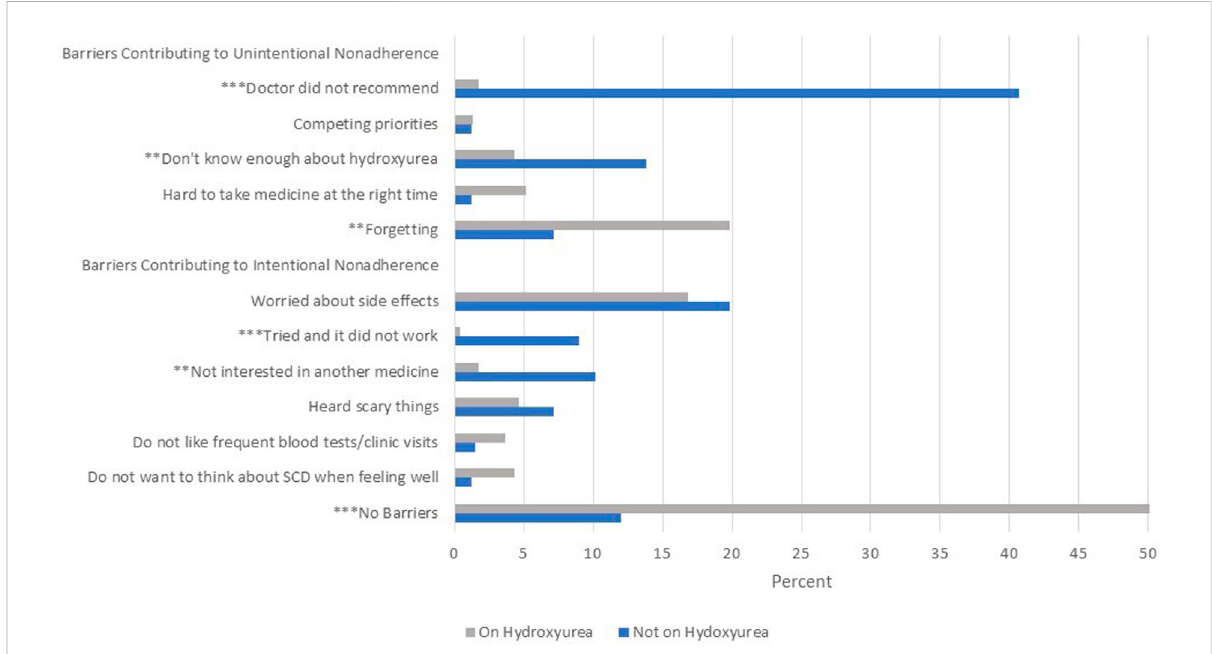
FIGURE 1 Barriers to hydroxyurea use as reported by adults and caregivers of children with sickle cell disease (SCD). Notes: Side effects worried about included cancer, hair loss, nail discoloration, nausea/dizziness. “ Scary ” things heard about included cancer, infertility, risk of infection and hair loss. ** p < 0.001 *** p <